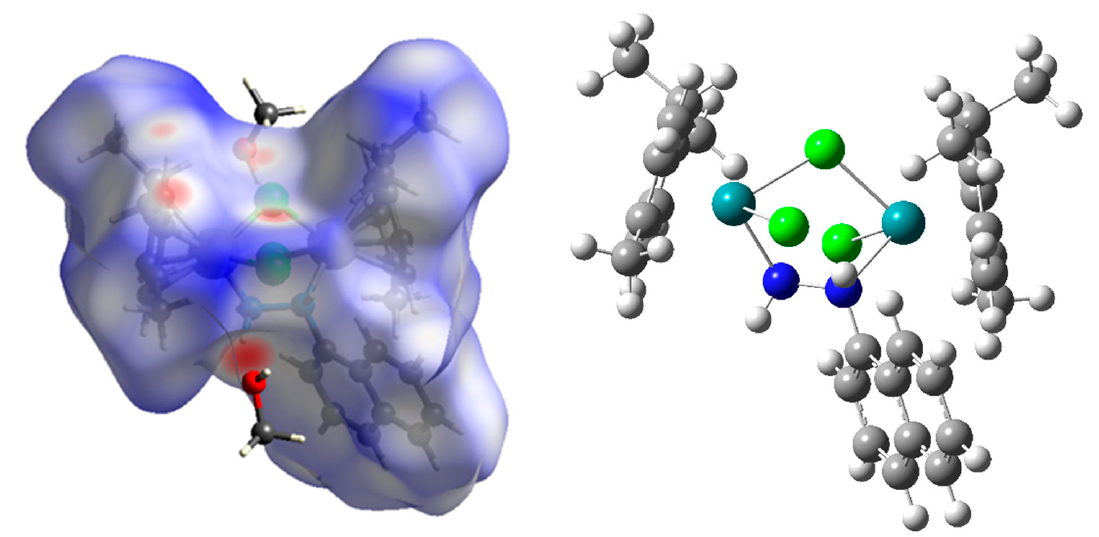
Figure 4. The Hirshfeld surface ( left ) and optimized structure ( right ) of 2a (the following colors represent atoms white-hydrogen, grey-carbon, blue-nitrogen, green-chlorine, teal-ruthenium).